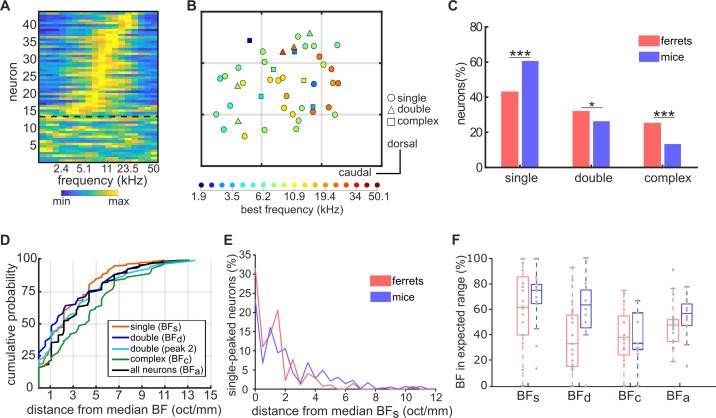
Similar tonotopic organization in the primary auditory cortex of ferrets and mice.(A) Frequency-response profile (i.e. level-averaged tuning curves) of all neurons imaged in one imaging field in one mouse. Data are presented as in Figure 1C. (B) Map of the anatomical locations of the neurons in (A), plotted as in Figure 2B. Neurons are color-coded according to their BF, and their shape corresponds to their FRA class. Each gray grid corresponds to a cortical area of 100 x 100 µm. (C) Proportion of frequency-sensitive neurons from each FRA class for ferrets (red) and mice (blue). The results of Likelihood Ratio tests are indicated above (*p < 0.05 and *** p < 0.001). (D) Cumulative probability plots of the difference (octaves/mm) between the BF of each neuron and the median BF of all neurons in the same imaging field. As in Figure 2C, distributions were calculated separately for BFs (orange), BFd (dark blue), peak 2 of double-peaked neurons (light blue), BFc (green), and BFa (black). (E), Distributions of the distance in octaves per mm between the BFs of each single-peaked neuron in an imaging field and the median BF of these neurons. Data are shown for ferrets (red) and mice (blue). (F) Box plots showing the percentage of neurons having a BF within the expected frequency range, given the species, size and average BF of each imaging field. Percentages were calculated separately for BFs, BFd, BFc and BFa, and percentages for individual imaging fields are shown as gray dots. Boxplots for ferrets (red) and mice (blue) show the median, upper quartile, and lower quartile of each dataset.